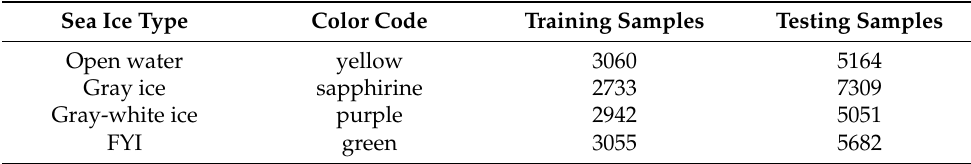
Table 4. Numbers of the training/testing samples and the color codes of sea ice types in Image I.